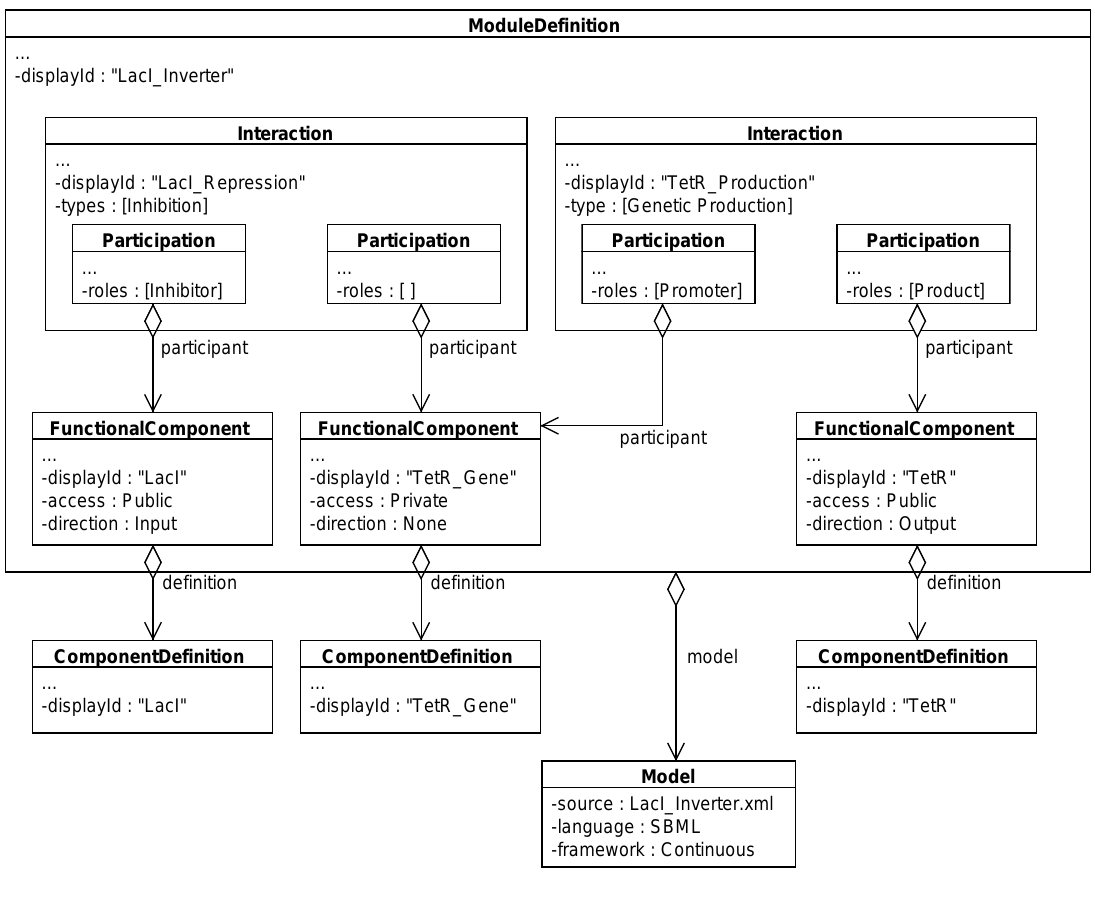
Figure 27: ModuleDefinition of the LacI inverter. This ModuleDefinition contains FunctionalComponent ob- jects that instantiate the ComponentDefinition objects for the LacI/TetR transcription factors and TetR gene. These FunctionalComponent objects participate in a repression Interaction and a genetic production Interaction , thereby indicating which biological structures carry out the function of the LacI inverter ModuleDefinition . In this case, the transcription and translation of TetR are represented as a single genetic production Interaction that abstracts away the presence of the intermediate TetR mRNA. In addition, this ModuleDefinition is also associated with a continuous Model written in the SBML source file